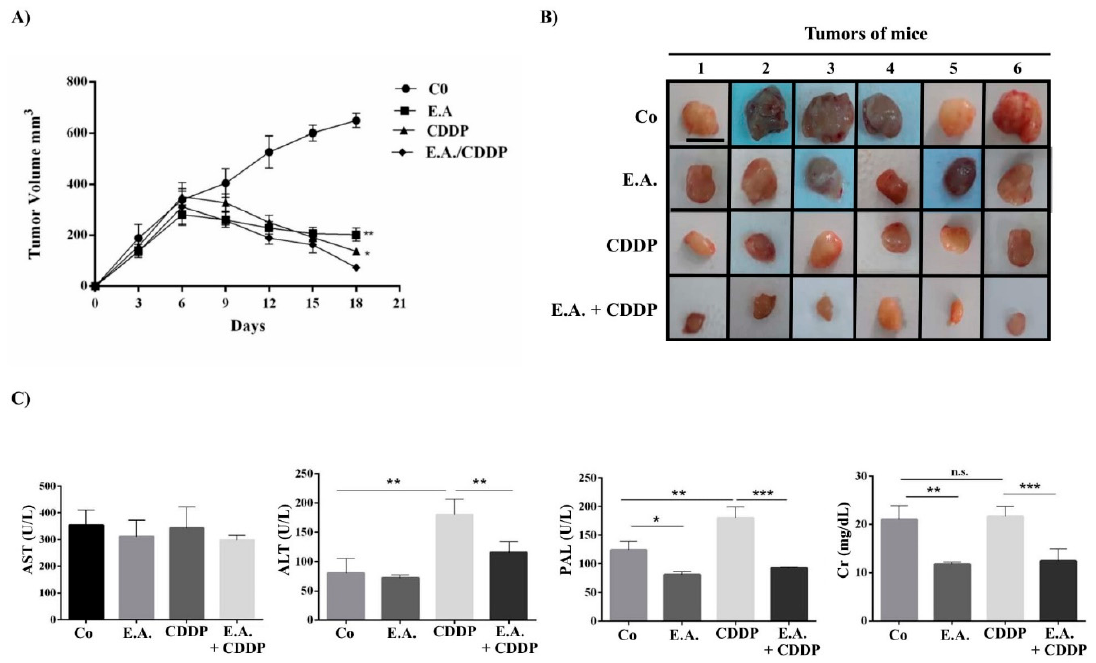
Figure 7. E.A. / CDDP combination synergized to inhibit tumor growth and to prevent hepato- and nephrotoxicities of CDDP. ( A ) Eight-week-old BALB / c female mice were injected in the mammary fat pad region 1 × 10 6 4T1 cells, and then each group of mice (six per group) was treated at the seventh day with sterile saline (control group; Co), E.A. (150 mg / kg), CDDP (20 mg / kg), or with E.A. (150 mg / kg) and CDDP (20 mg / kg) combination. Tumor size in cubic millimeters over time is represented as median ± standard error of the mean (SEM). ( B ) Xenograft tumors from mice groups (six per group were harvested at day 18; scale bar = 1 cm). ( C ) Biochemical analyses of the serum from mice groups for aspartate transaminase (AST), alanine transaminase (ALT), creatinine (Cr), and phosphatase alkaline (PAL). The data are means ± standard deviation (SD) of three independent experiments; p -values were determined by the multiple ANOVA test. * p < 0.05, ** p < 0.01, *** p < 0.001.